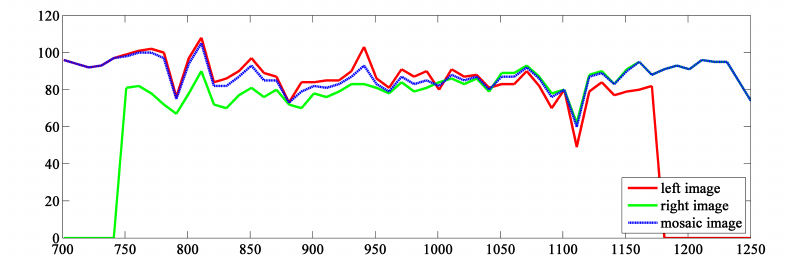
Figure 7. Schematic of gray value. The horizontal axis is the X -coordinate of pixel. The vertical axis represents the corresponding gray value.